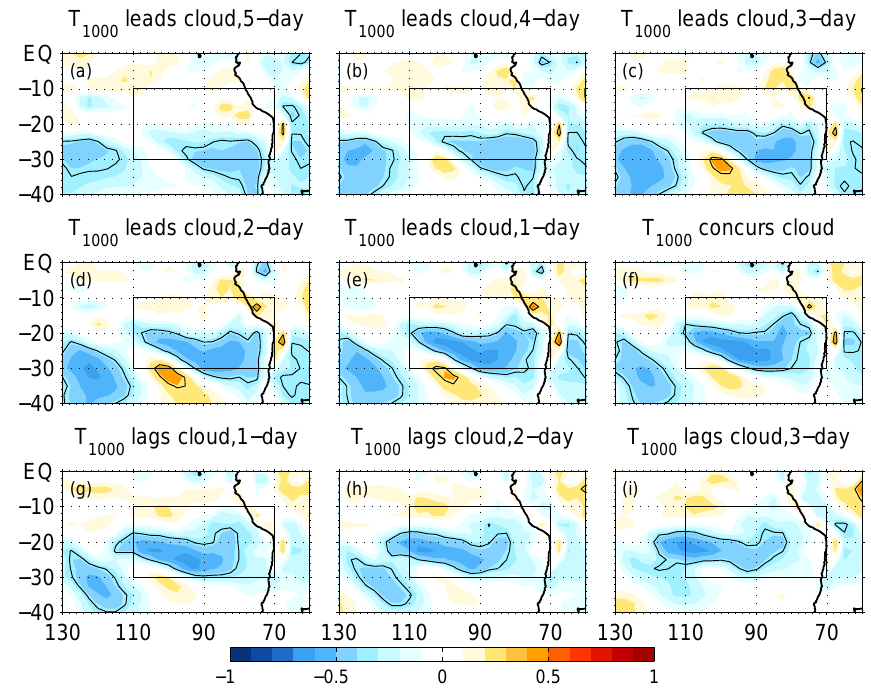
Fig. 11. Same as Fig. 10, but with temperature at